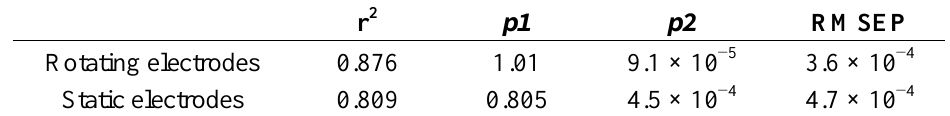
Table 2. The adjusting parameters (r2, p1, p2 and RMSEP) from the PLS prediction models for the data from the validation